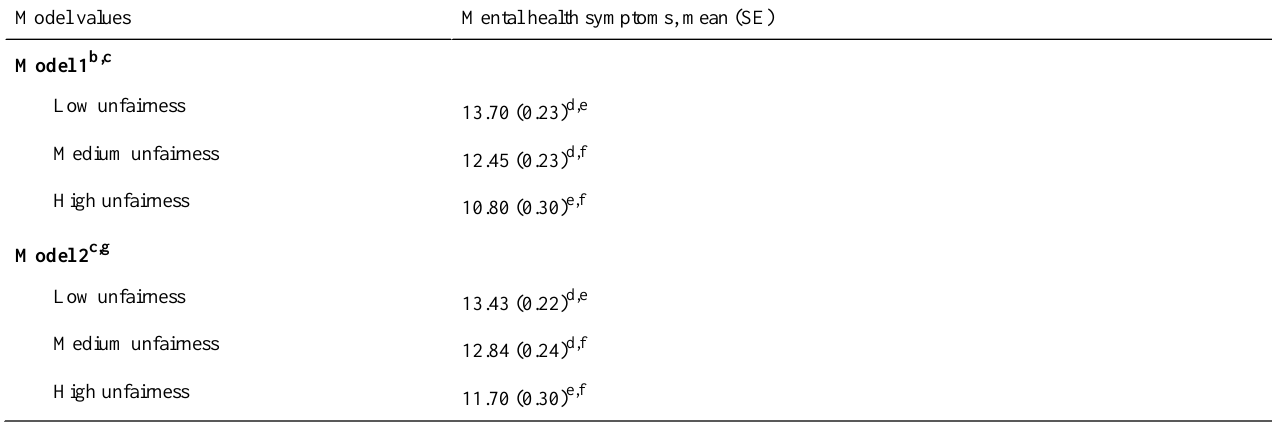
Table 3. Adjusted least squares mean mental health symptoms by unfairness and discrimination a .